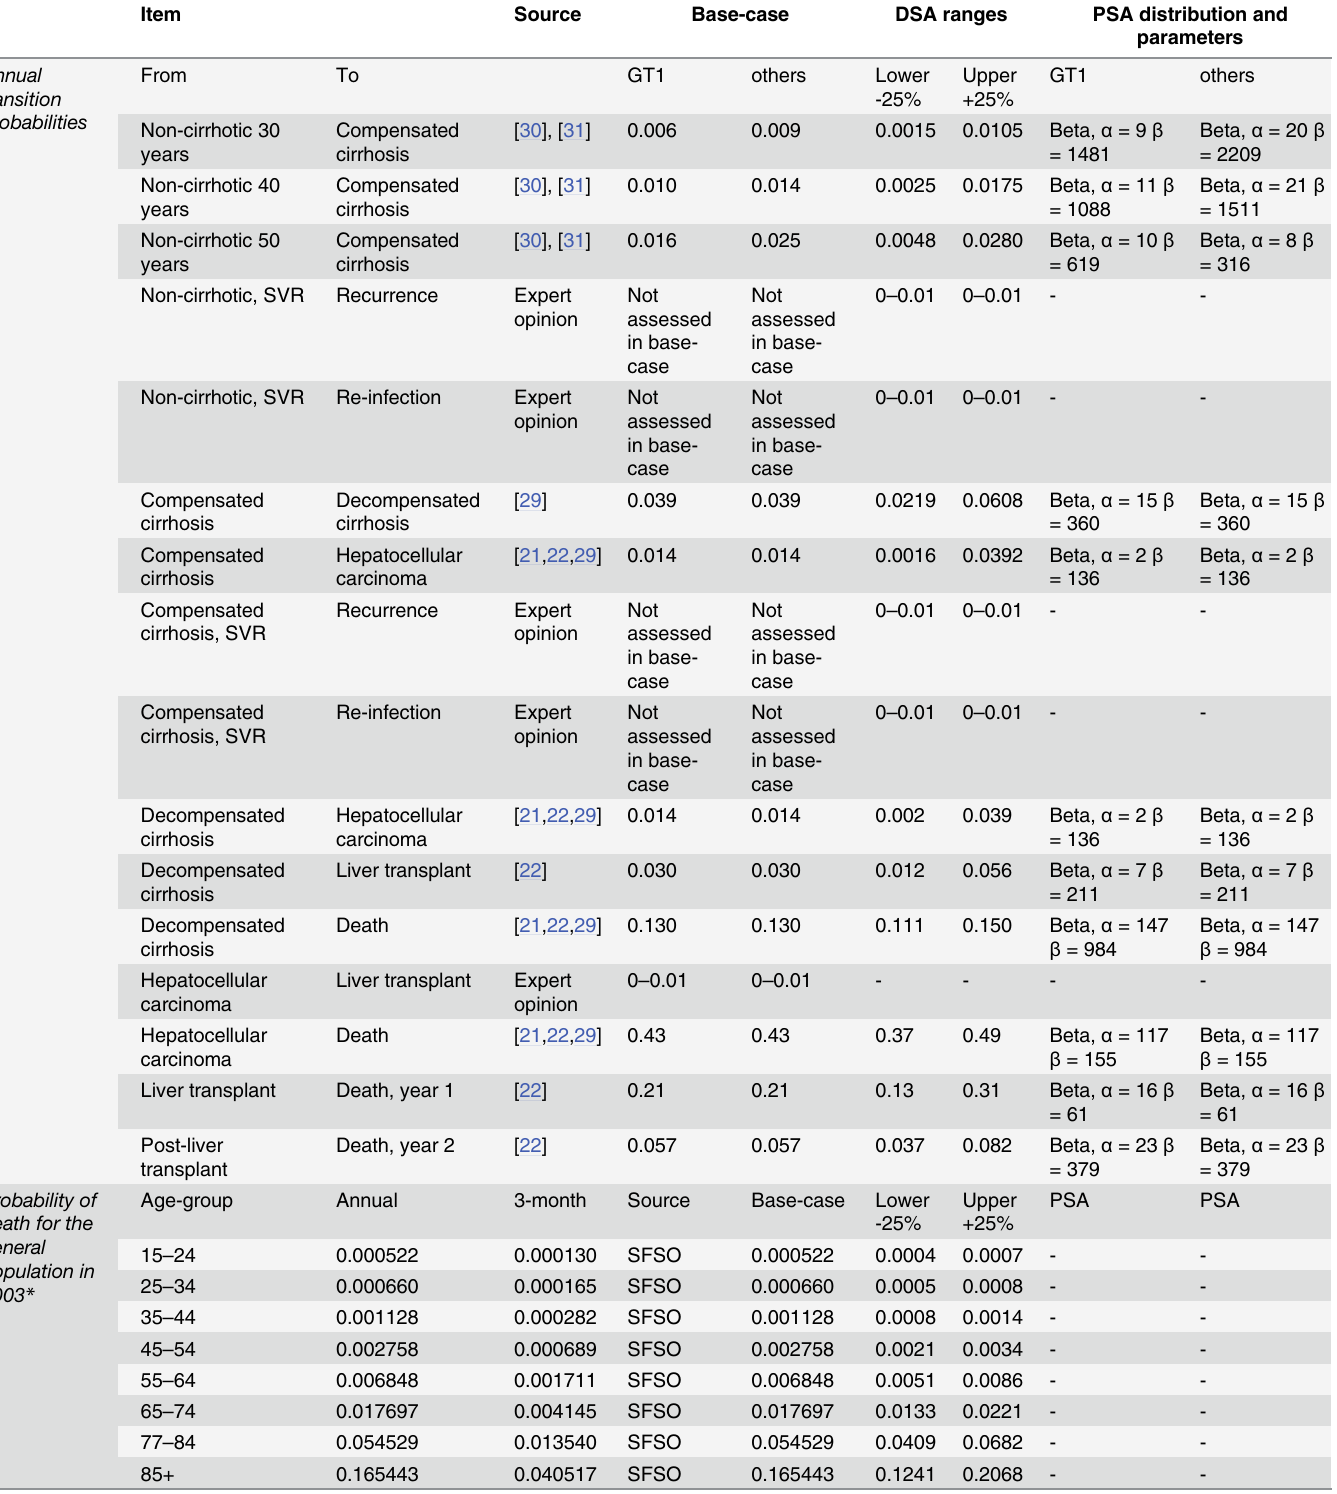
Table 1. Base-case values for model input parameters and ranges used in the sensitivity